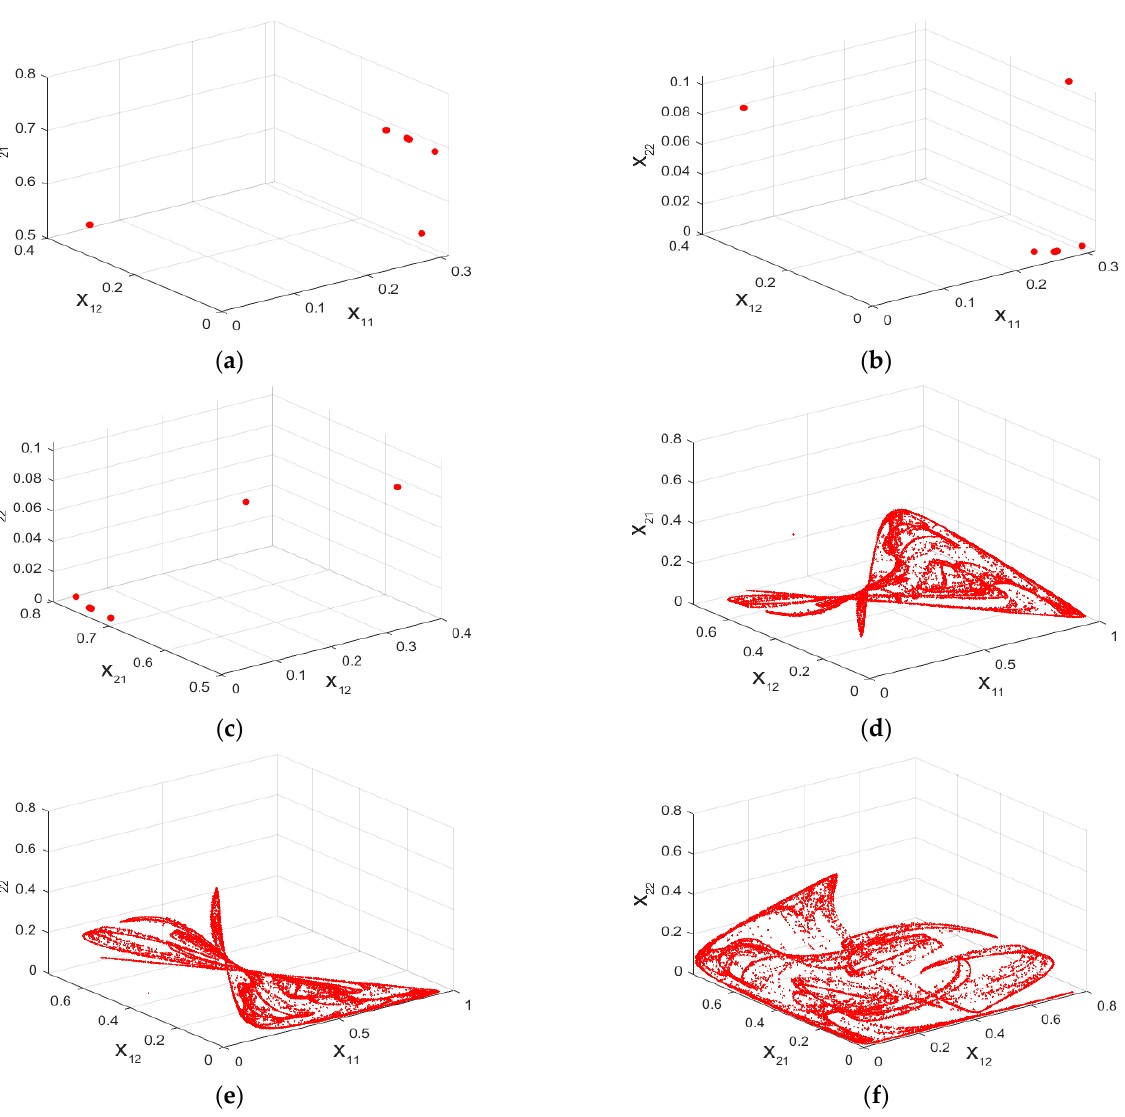
Figure 1. Traffic network topology. Figure 1. Tra ffi c network topology. Figure 1. Tra ffi c network topology.